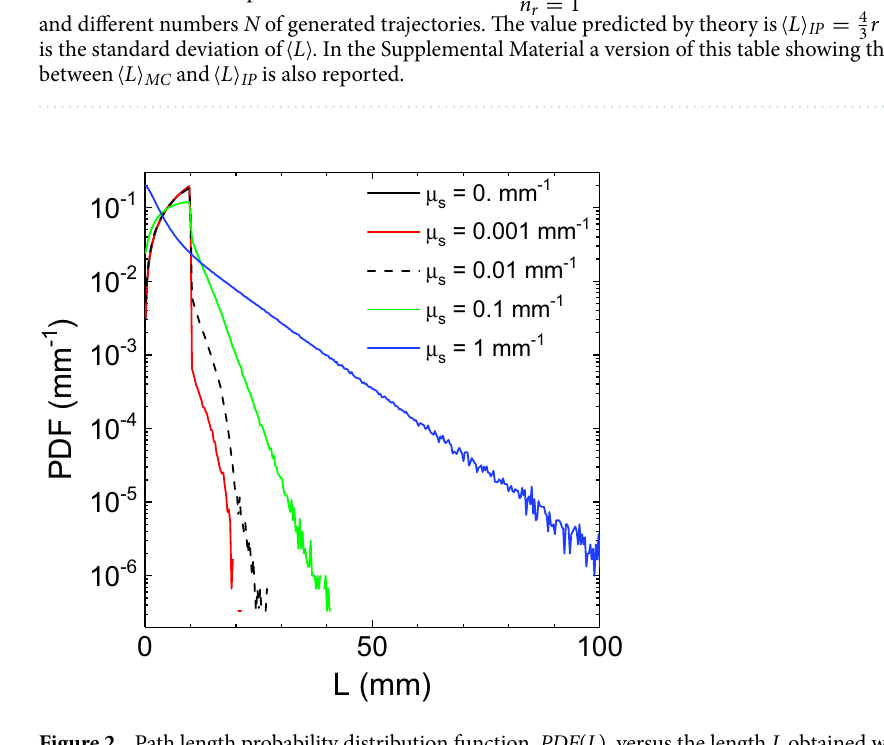
Figure 2. Path length probability distribution function, PDF ( L ), versus the length L obtained with MC simulations for a sphere of 5 mm radius, n r undistinguishable from the case µ s = 0.001 mm − L > 10